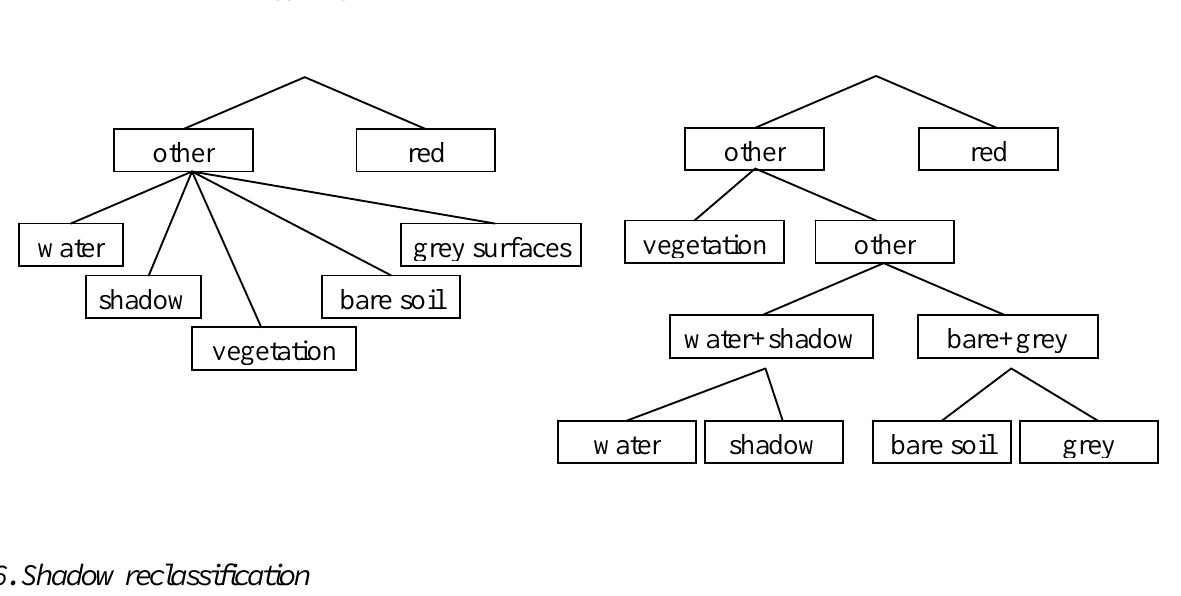
Figure 3. Classification strategies: two-step classification strategy (left) and full hierarchic classification strategy